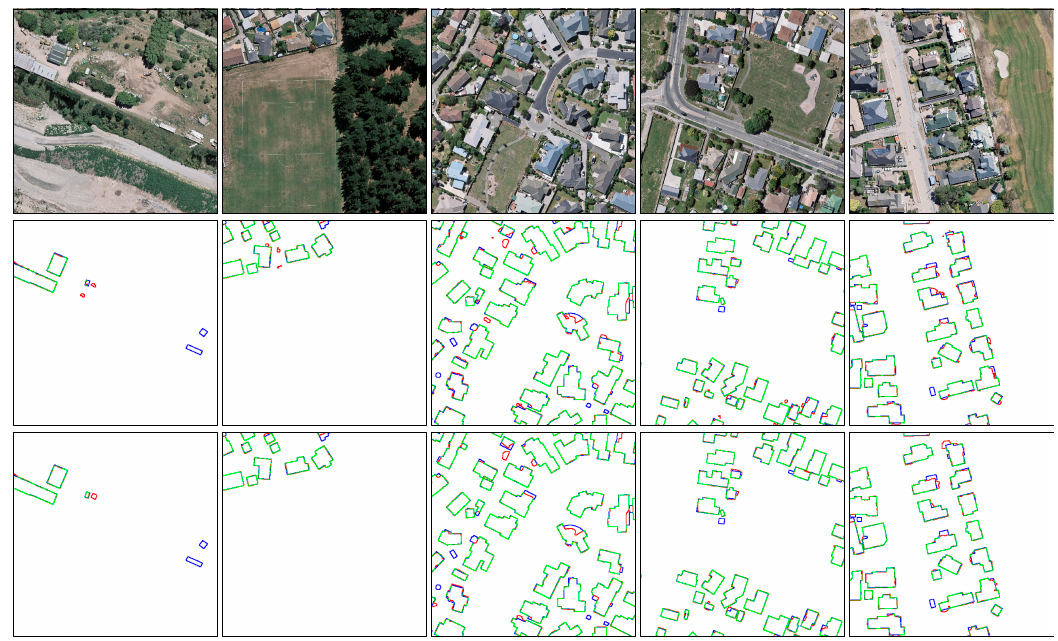
Table 4. Predicted boundary performance on the WHU dataset.